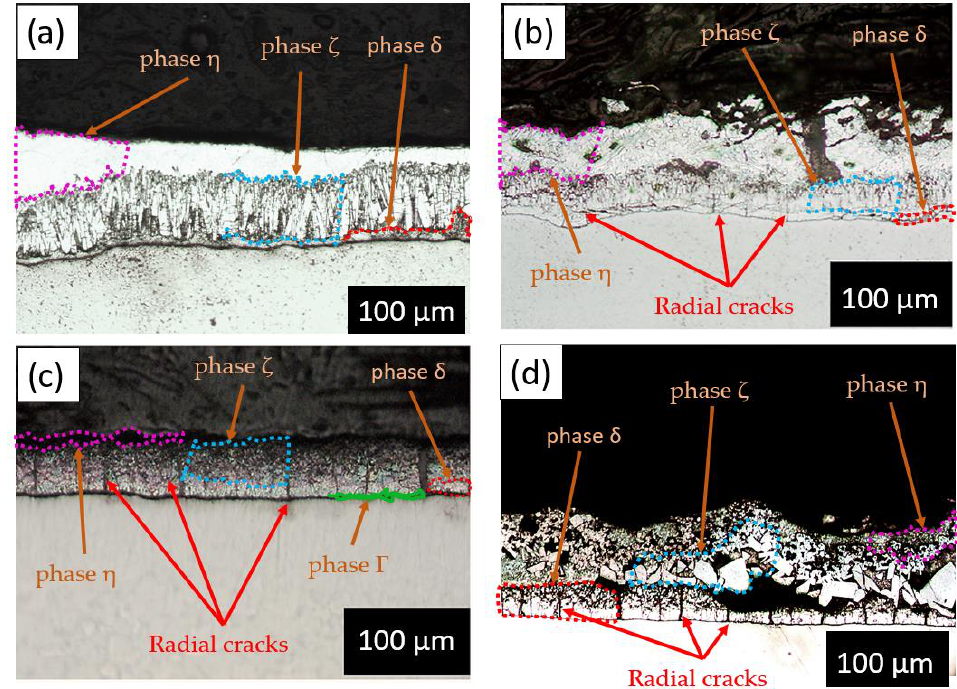
Figure 9. Metallographic analyses of coatings sections for: ( a ) Pure Zn — 60 s; ( b ) Zn-Sn3% — 60 s; ( c ) Z-Cu0.5% — 60 s; ( d ) Zn-Ti 0.5% — 60 s.